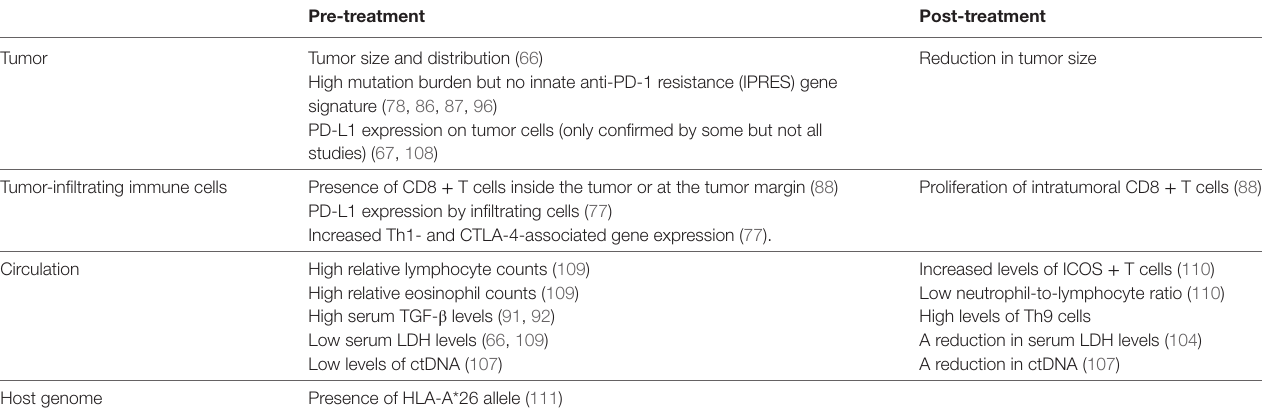
TAbLe 3 | Biomarkers associated with favorable responses to immune checkpoint